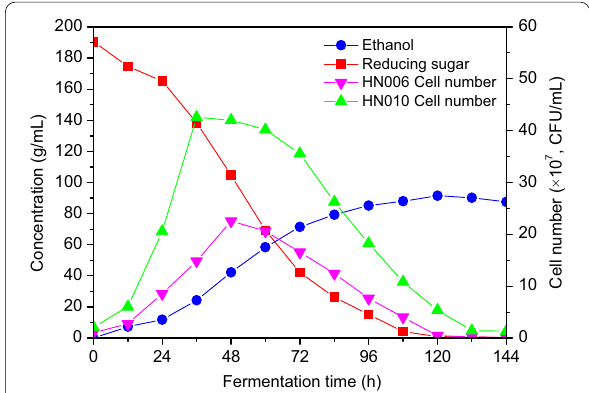
Fig. 4 1000L fermentation profiles of Chinese chestnut wine with co-culture of strain HN006 and strain